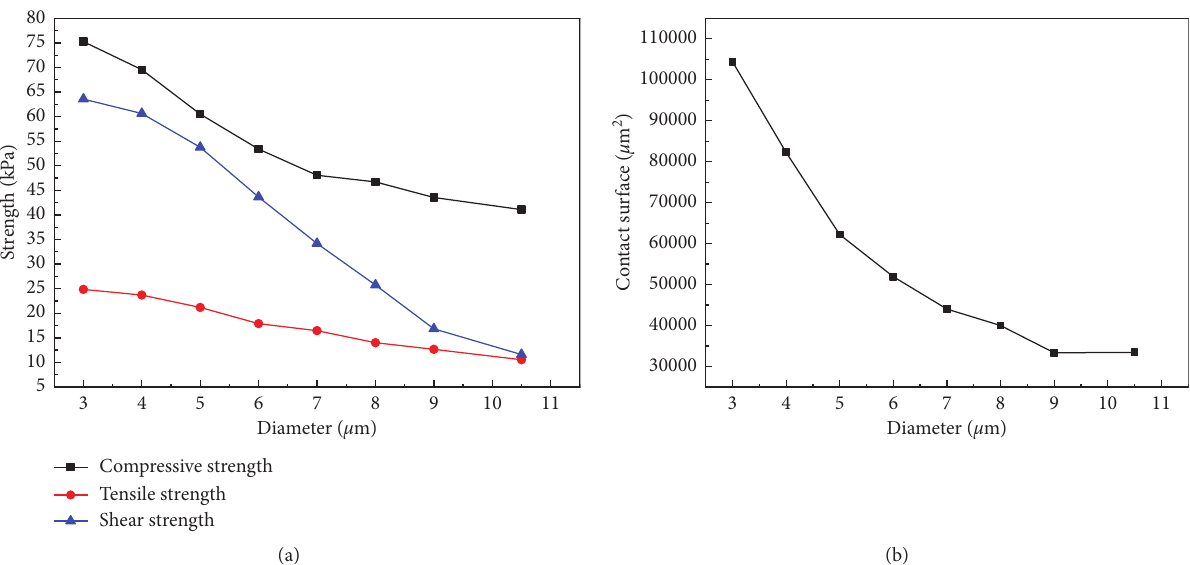
Figure 8: (a) Mechanical properties of RWB with different fiber diameters (SVF � 4.72%); (b) relationship between the fiber contact area and diameter (SVF �